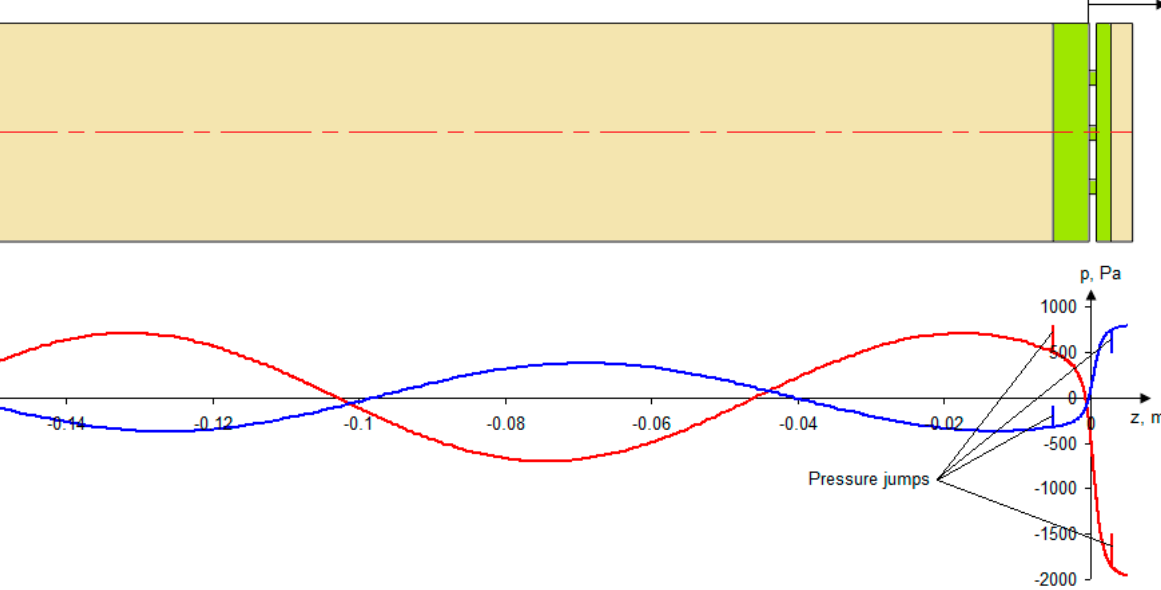
Table 2. Basic parameters of the numerical simulation.